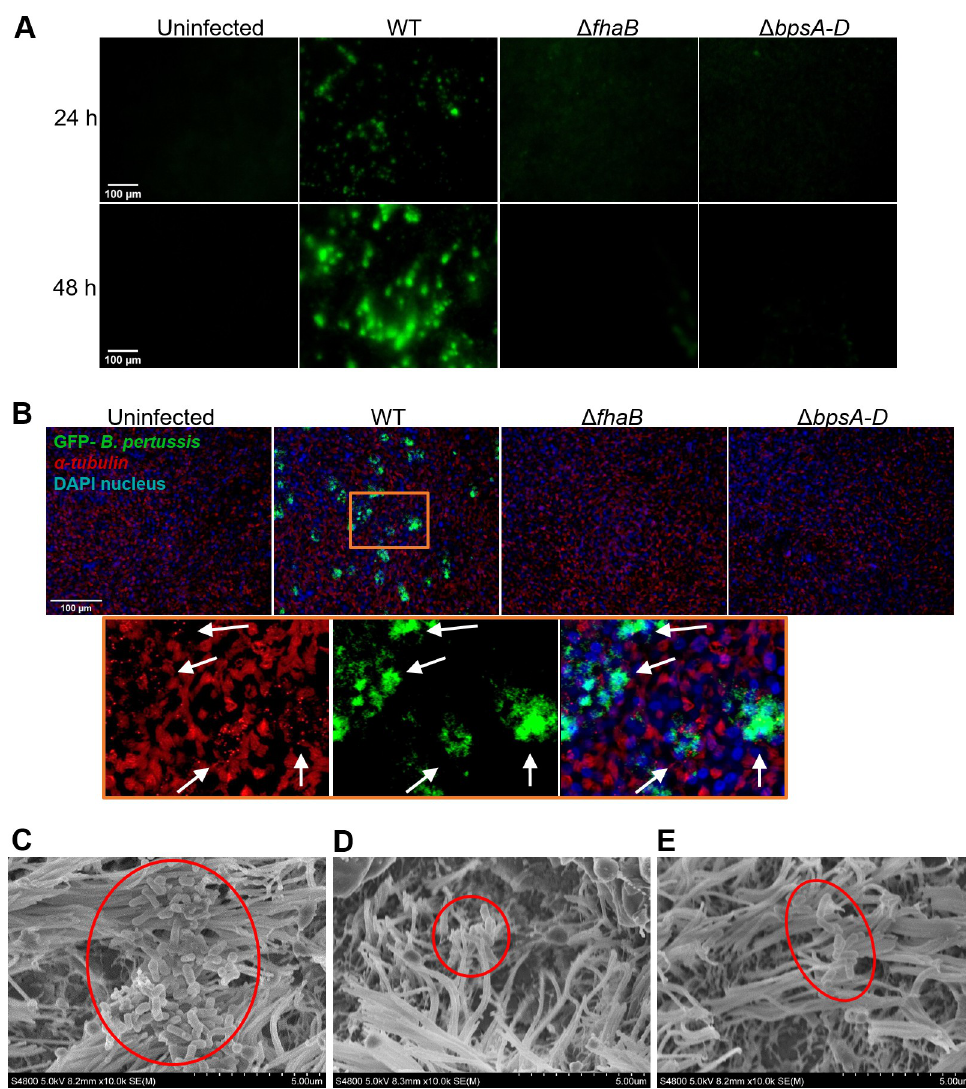
Fig 3. Bp forms aggregates and clusters on HBE cells. (A) Representative live cell images of GFP-labeled bacteria on apical surface of HBE cells after 24 and 48 h (10X objective). (B) Immunofluorescent staining of α -tubulin (cilia) and DAPI (nuclei) on fixed HBE cells infected with GFP-labeled bacteria after 48 h (10X objective). Zoomed in image of HBE cells infected with the WT strain showing colocalization of bacterial aggregates with punctate acetylated- α -tubulin staining (arrow). (C-E) Scanning electron microscopy of Bp strains 24 h after infection of HBE cells. All images are representative of three biological replicates.